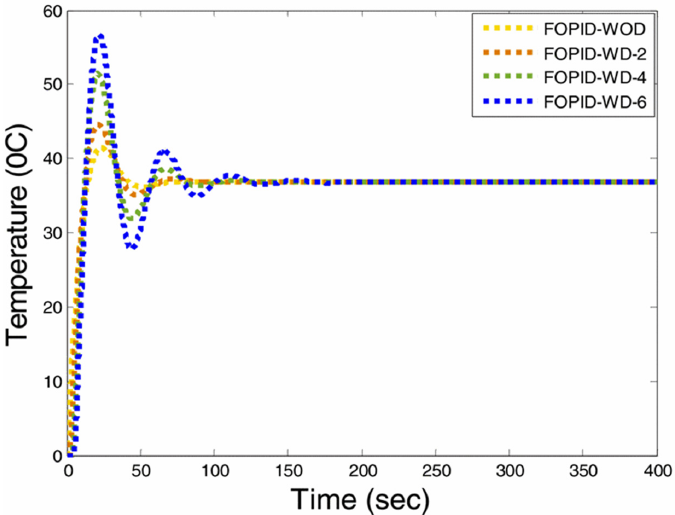
Figure 13. Output plot comparison of ambulance response with fractional-order PID .